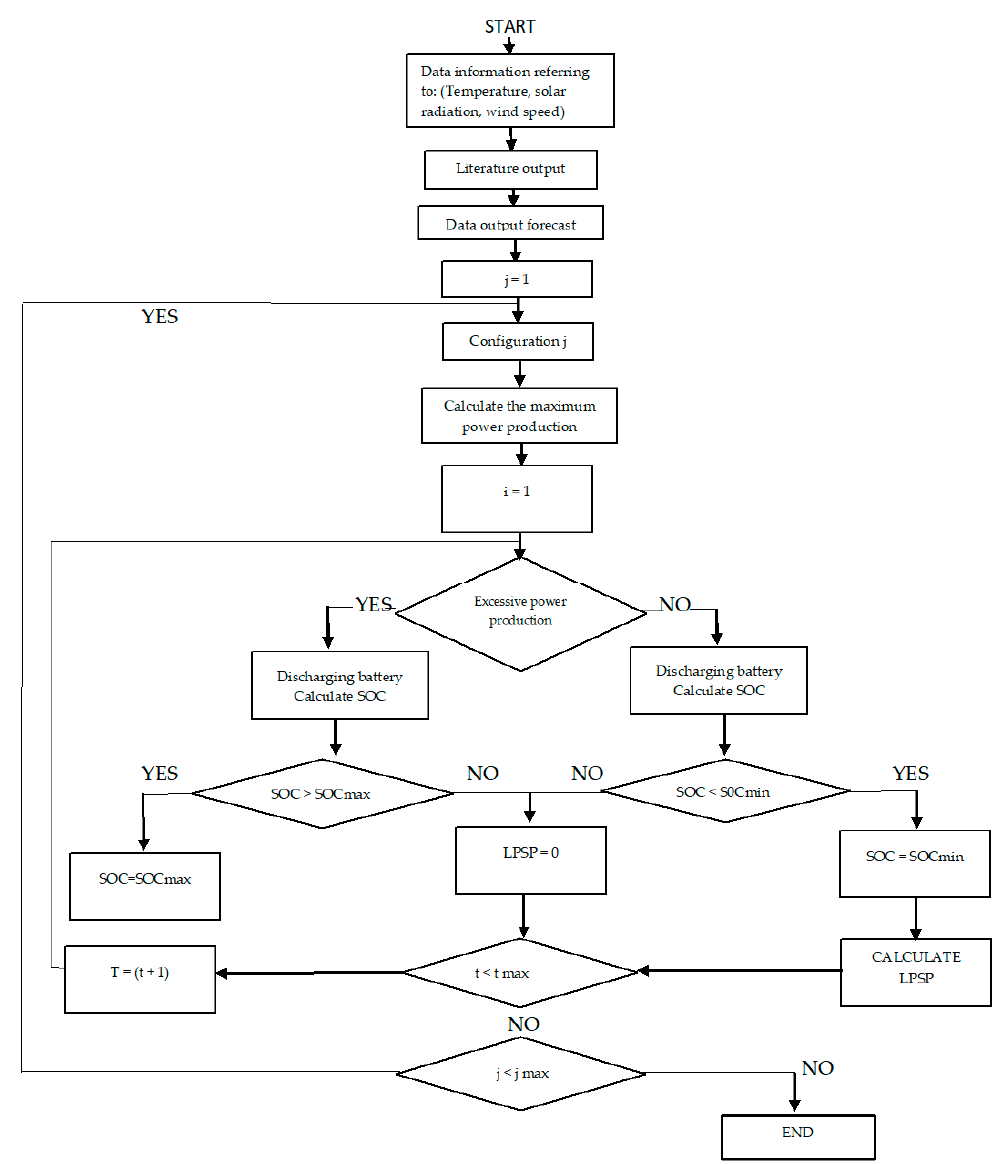
Figure 10. Flow diagram of the process for supplying energy to organic construction.